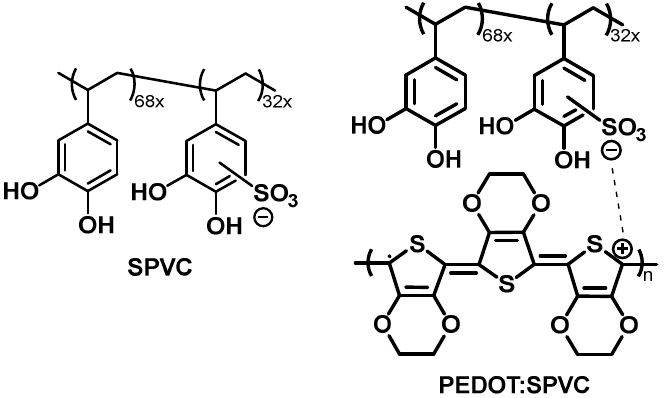
Figure 1. Chemical structure of the SPVC polyanion previously developed by our group and schematic representation of the PEDOT:SPVC material.